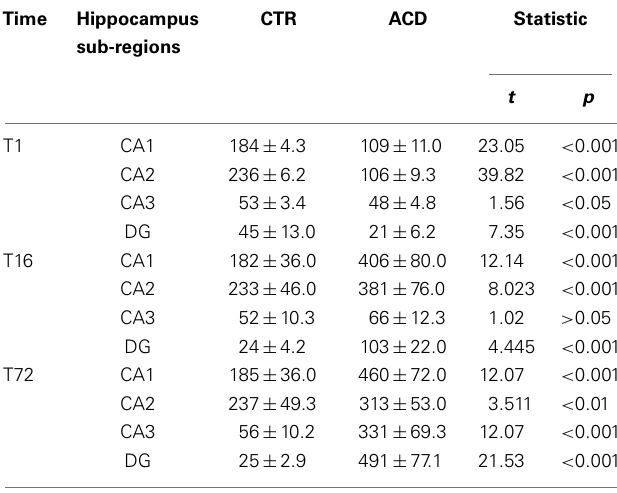
Table 2 | Number of NPY-positive neurons in different sub-regions of the hippocampus, inACD and in control rats, at different times following the last intragastric infusion (T1,T16,T72) .